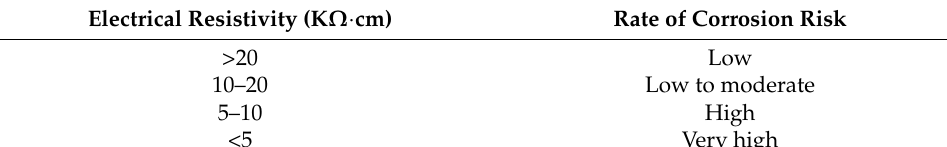
Table 5. Correlation between electrical resistivity and corrosion rate [35].